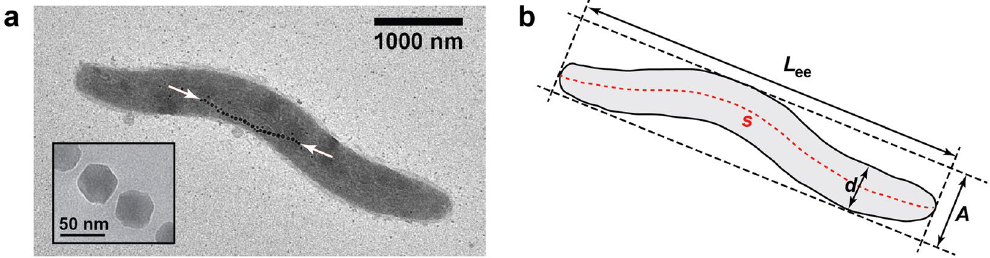
Figure 1. The magnetotactic bacterium Magnetospirillum gryphiswaldense . The bacteria possess a helical shape with a length of several micrometers and a diameter of approximately half a micrometer. An intracellular chain of magnetosomes allows them to navigate along magnetic fields. ( a ) Transmission electron microscopy image of a cell with a chain of approximately thirty magnetosomes (white arrows). The inset shows a high resolution image of magnetosomes from another cell. ( b ) We parameterize the helical shape of the cells by the end-to-end length L ee , the diameter d , the arc length s and the amplitude A of the